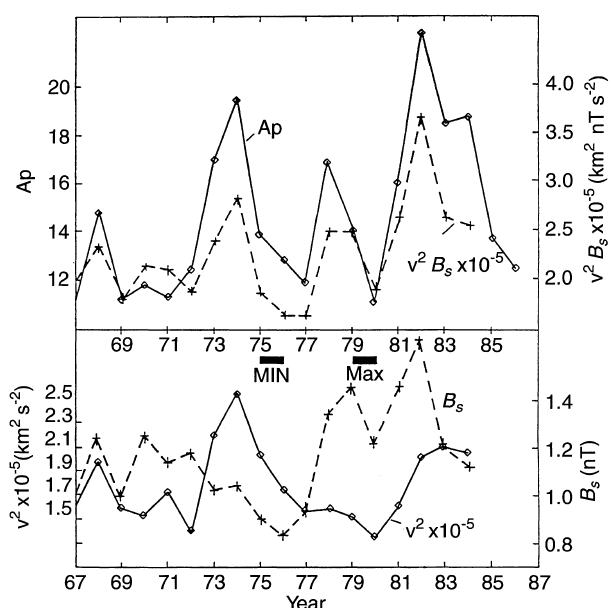
Fig. 1. Yearly averages of Ap and (cid:109) 2 B s = 10 5 for the years 1967–1984 (to 1986 for Ap) upper part , and yearly averages of the southward IMF component B s and (cid:109) 2 = 10 5 lower part ; maximum and minimum years of sunspot cycle 21